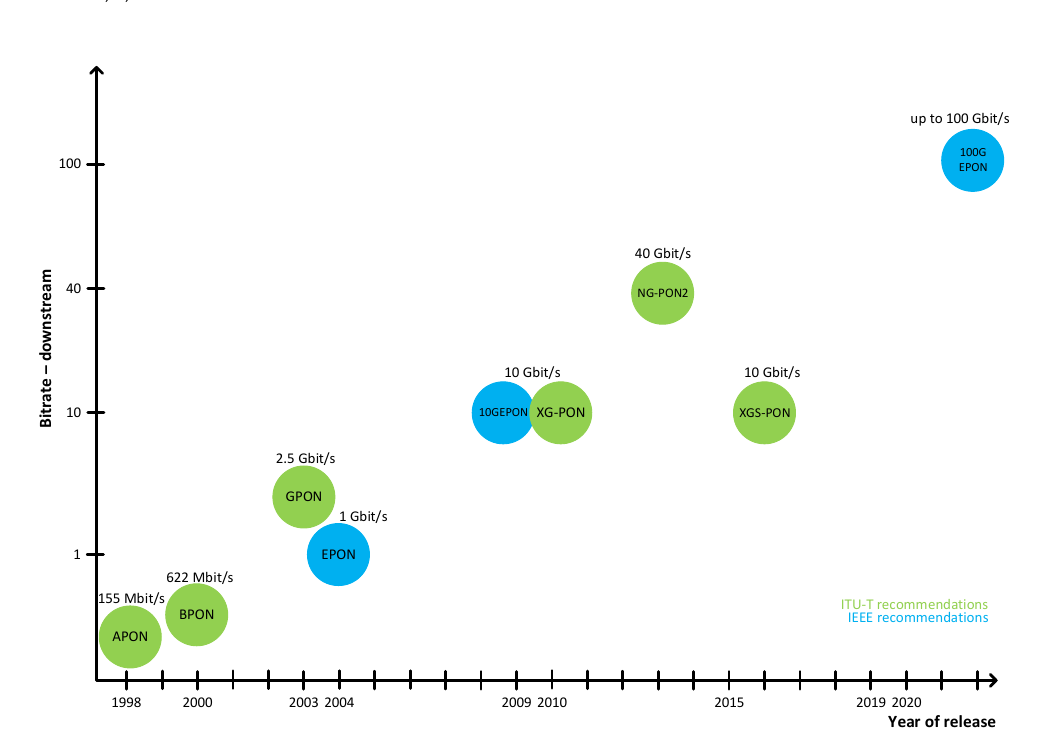
Figure 1. Passive optical network (PON) evolution